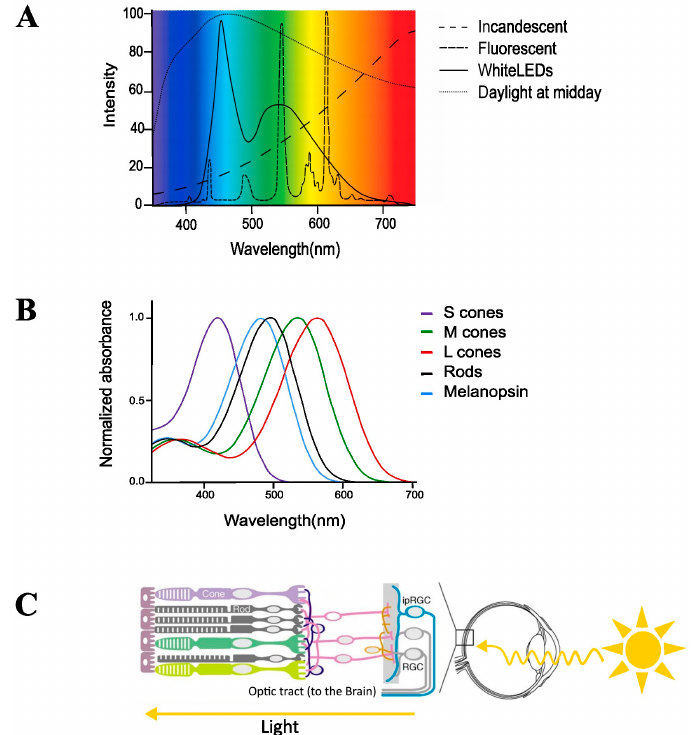
Figure 1. Photoreceptor sensitivities and light spectra. ( A ) Spectrum of white LED, fluorescent, and incandescent light sources and natural daylight. ( B ) Spectral sensitivities of retinal photoreceptors in primates. ( C ) Wiring and position of retinal photoreceptors. ipRGCs: intrinsically photosensitive retinal ganglion cells expressing melanopsin. RGC: retinal ganglion cells. Reproduced and adapted with permission from [14].